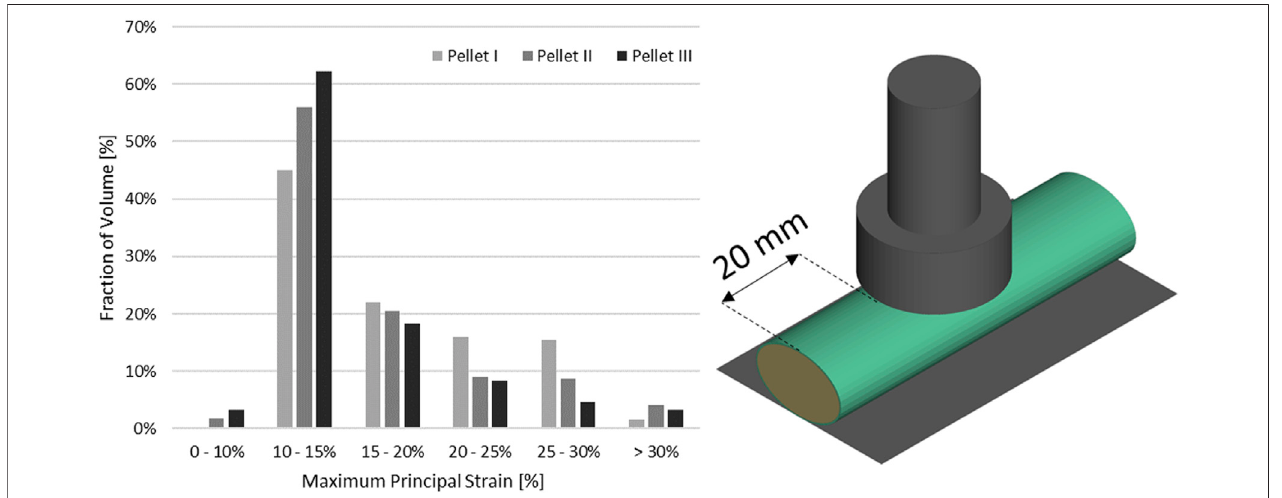
FIGURE 13 | Volume fraction of the pia mater that was subjected to maximum principal strain in the impact model in the vicinity of the impact.